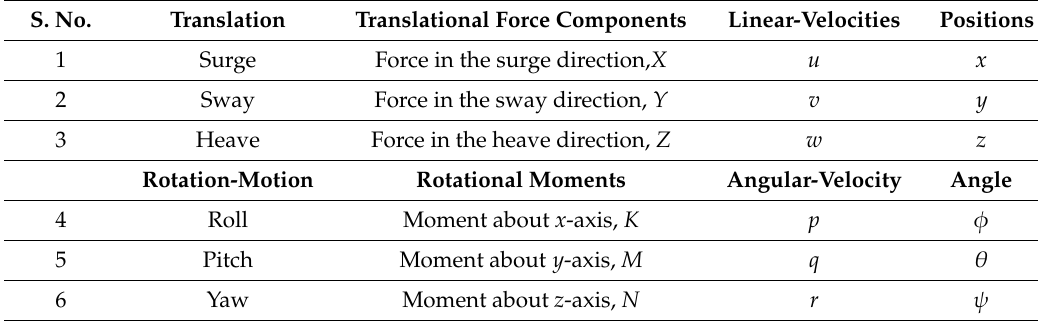
Table 3. List of the notations used in six degrees of freedom